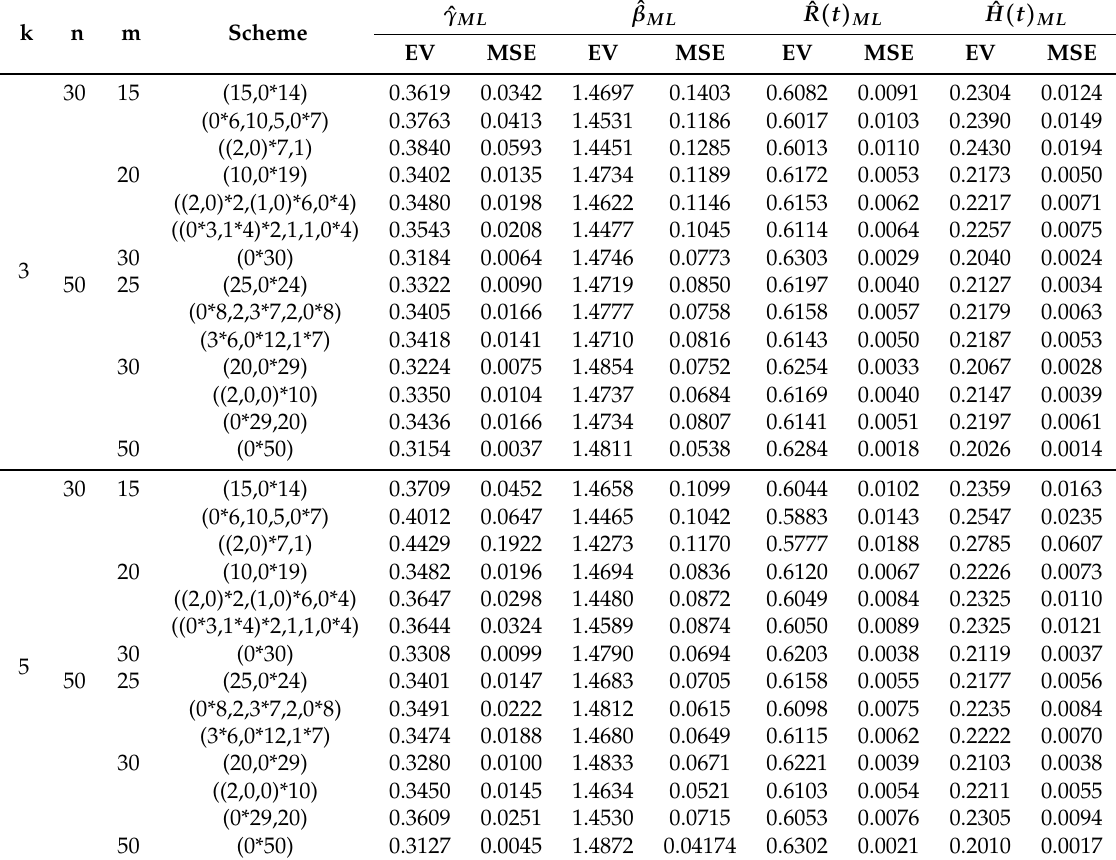
Table 1. Maximum likelihood estimates and MSEs of parameters and reliability and hazard